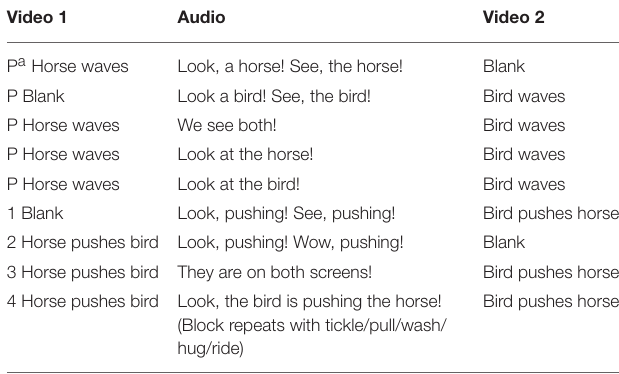
TABLE 3 | Sample layout of the word order